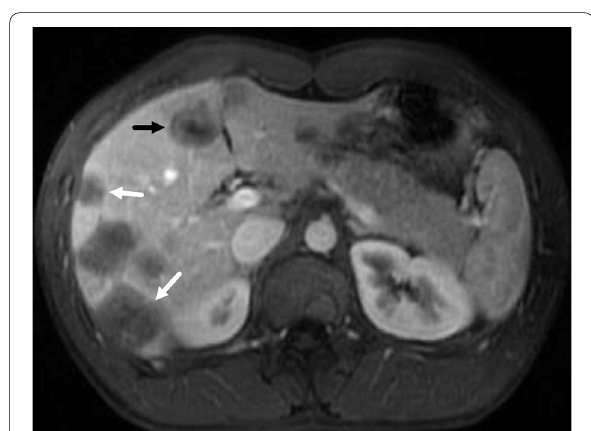
Fig. 5 A 22-year-old male HEH patient. On portal phase image, target sign could be observed on a medium lesion (black arrow), while both small and large lesions failed to show target appearance (white arrow)